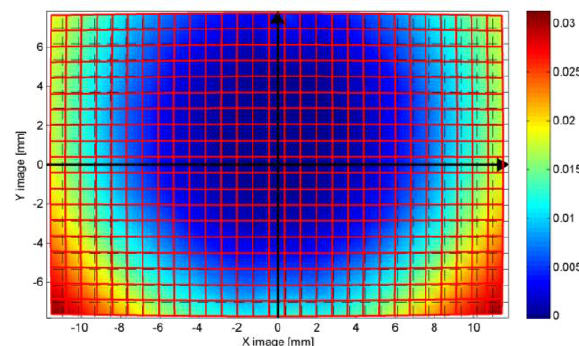
Figure 9. Difference between in air and in water distortion